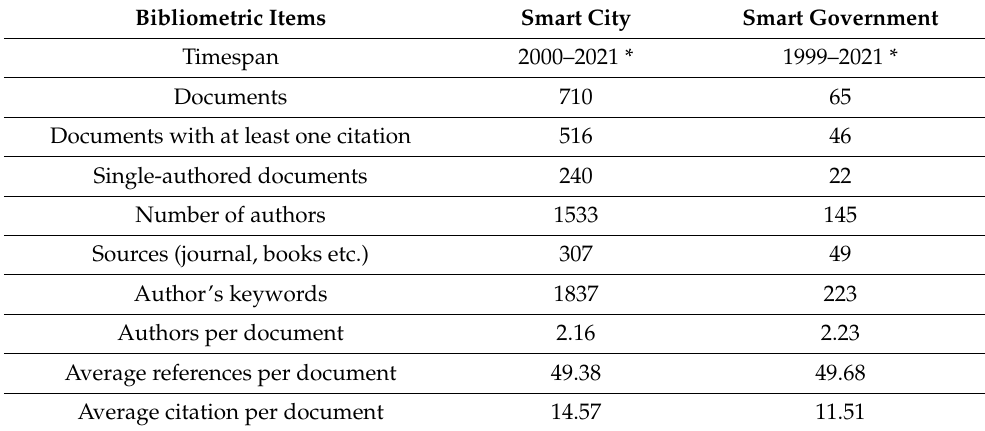
Table 1. Overview of characteristics of scientific literature on smart government and smart